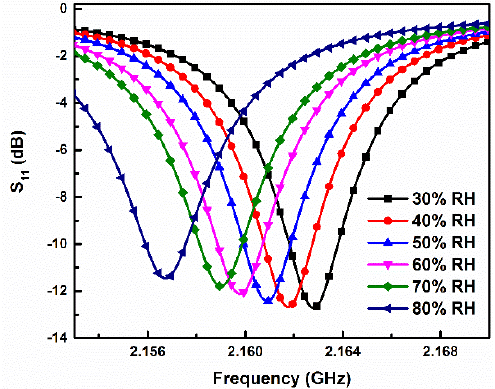
Figure 7. Measured reflection coefficients S 11 of the designed humidity sensor at different RH levels.